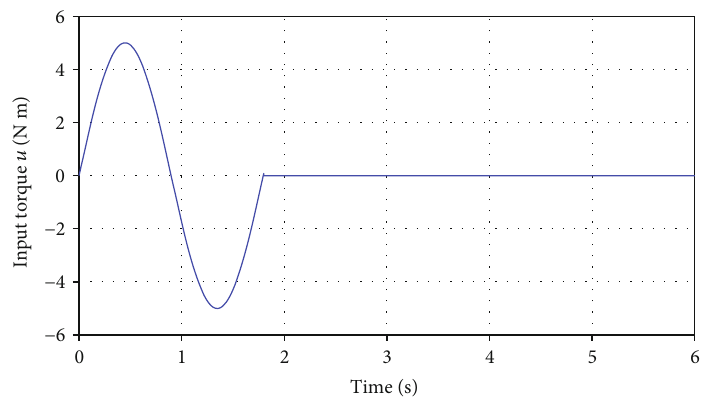
Figure 3: Designed input torque signal τ = 50 sin ð 3 : 5 t Þ ( 0 ≤ t ≤ 1 : 8s ).